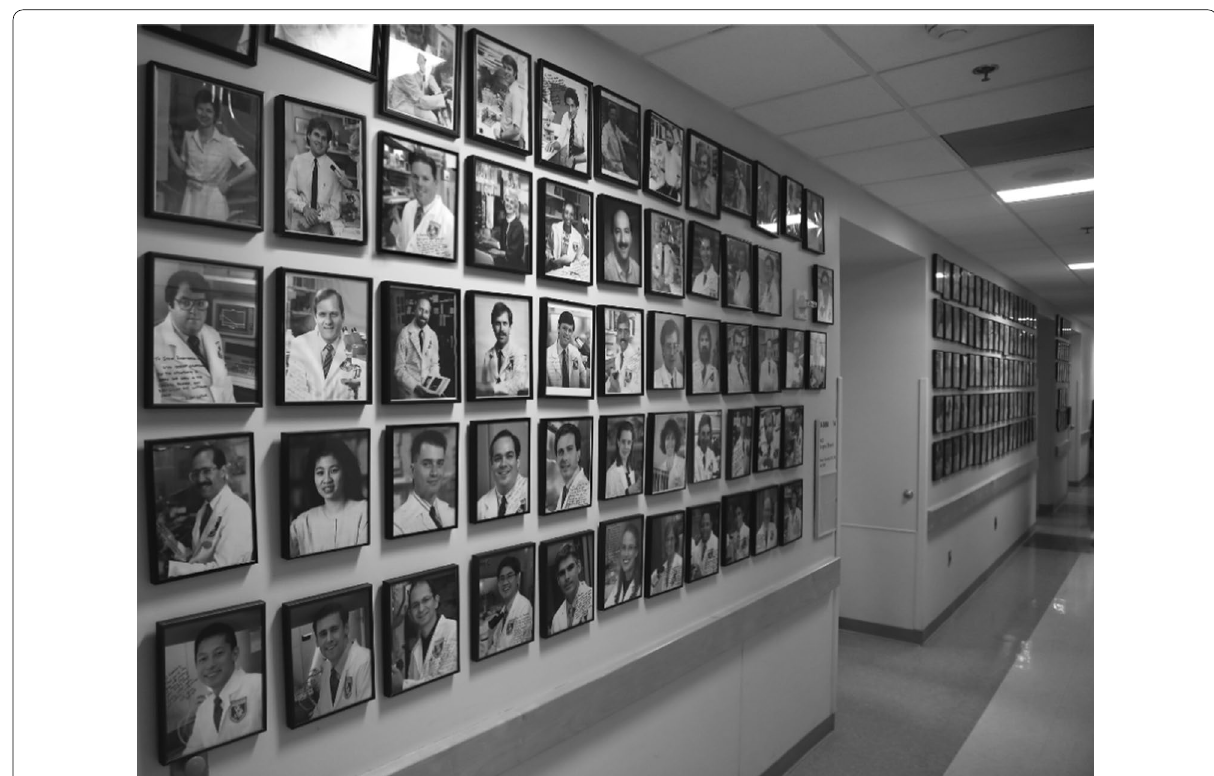
Fig. 8 Photos line the walls outside my office dedicated to the hundreds of fellows who worked in my laboratory and make important contributions to our